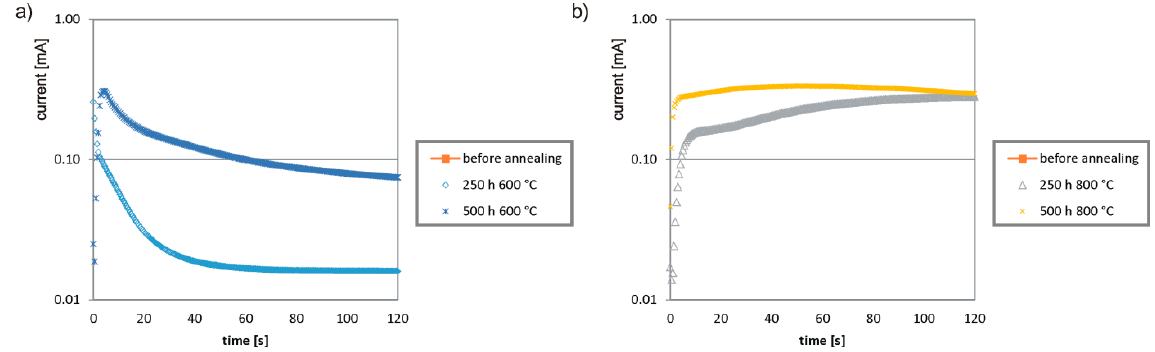
◦ C, ( b ) annealing at 800 ◦